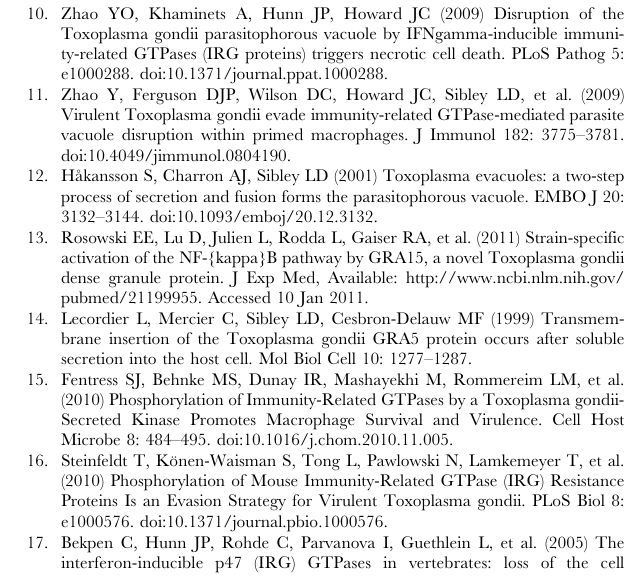
anti-FLAG antibody (Sigma-Aldrich) and a rat monoclonal anti- HA antibody (Roche Applied Science) were used to stain for HA-mGBP5 co-localized with mGBP1 at the PV of type II T.